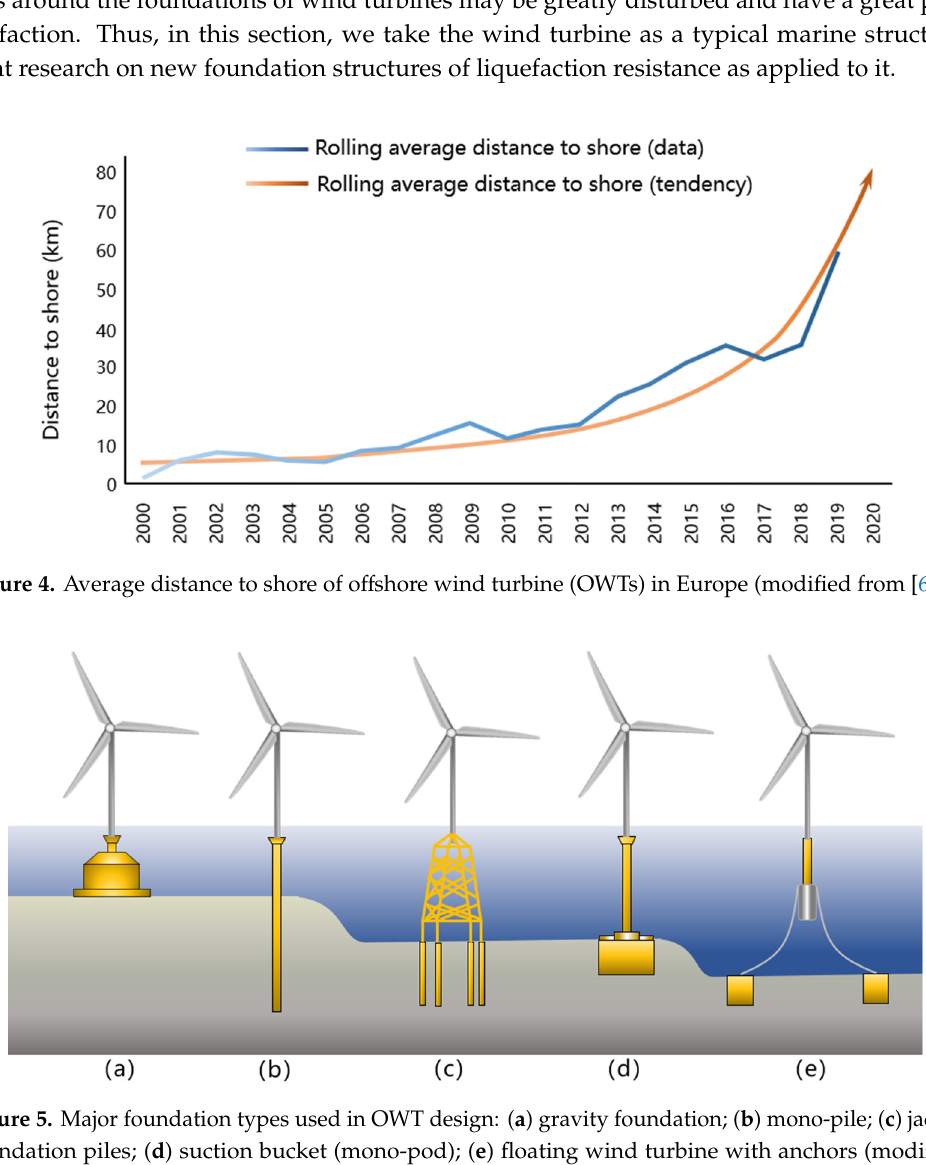
Table 2. Main OWT foundation types and novel liquefaction-resistant structure improvements (based on [2,26,68–71]).